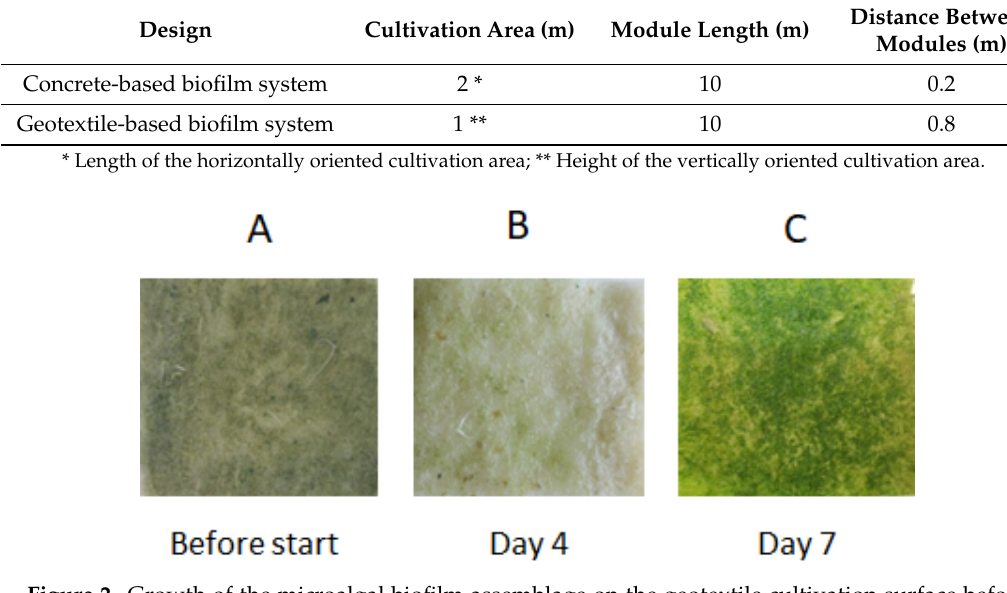
Figure 2. Growth of the microalgal biofilm assemblage on the geotextile cultivation surface before and during the experiment (after 4 and 7 days). The size of the geotextile patches was 3 × 3 cm. ( A ) Geotextile cultivation surface before the experiment. ( B ) Geotextile cultivation surface after 4 days of the experiment. ( C ) Geotextile cultivation surface after 7 days of the experiment.